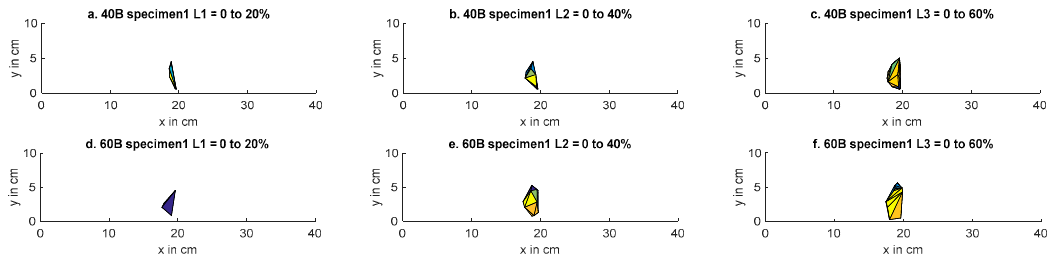
Figure 13. CHV progression seen from the top view ( x -and y -axis) for L1, L2, and L3 for specimens WC40B1 ( a – c ), and WC60B1 ( d – f ).